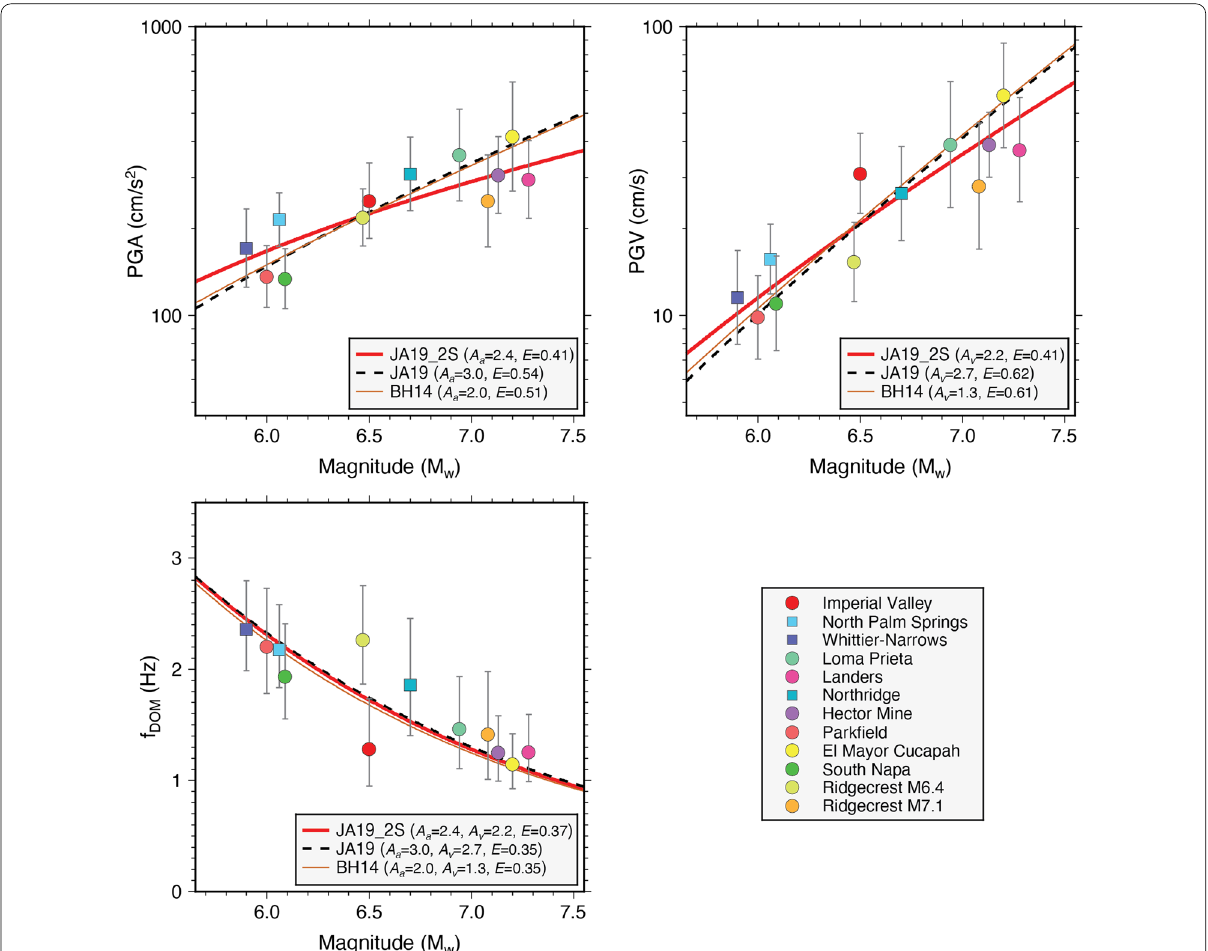
Fig. 16 Ground motion values from the lowest misfit validation simulations plotted as a function of magnitude for PGA (top left), PGV (top right), and dominant frequency (bottom left). The ground motions have been normalized to a distance of 10 km. Symbols are plotted at the median level and error bars denote the standard deviation. JA19_S2 and JA19 are double-corner-frequency models of Ji and Archuleta (2021), and BH14 is the single-corner-frequency model of Baltay and Hanks (2014). A a and A v denote the amplification factors applied to the empirical models for PGA and PGV, respectively, in determining the optimal fit to the simulated ground motions. E denotes the misfit given by Eq.